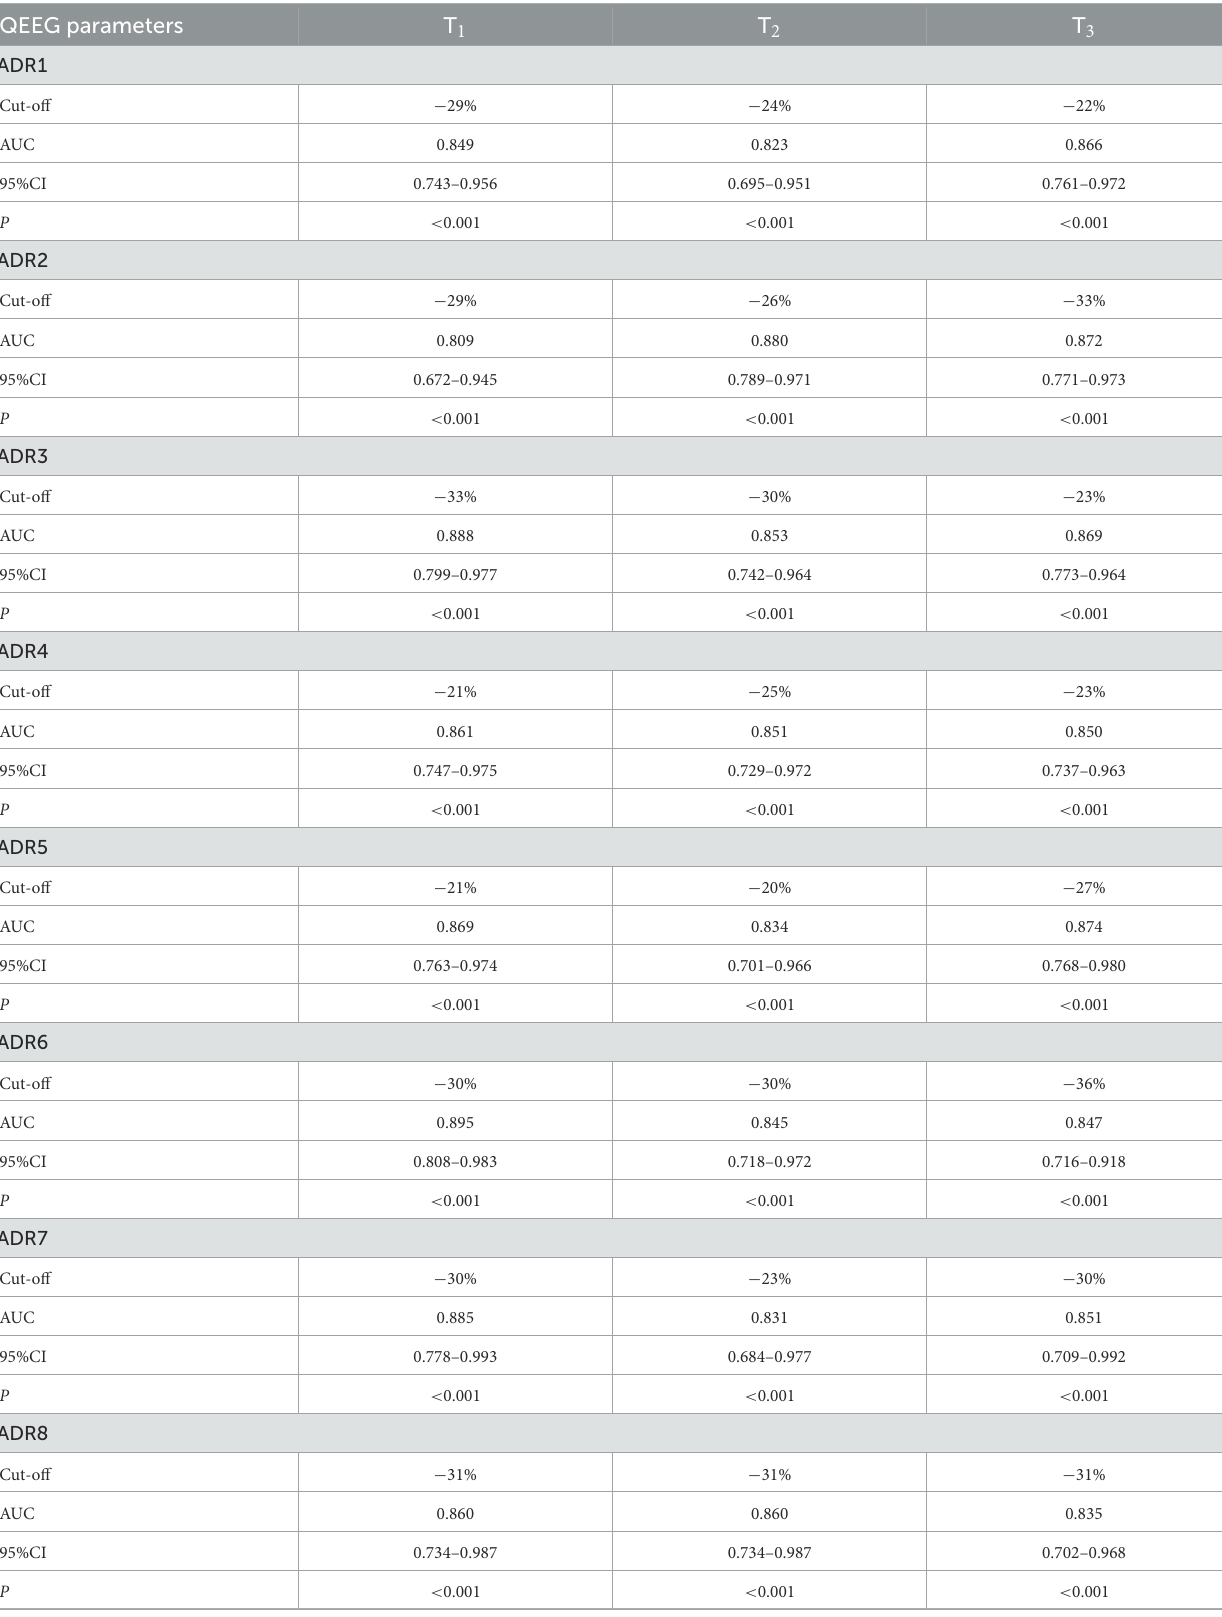
TABLE 3 ADR comparison of different leads at different time points on the surgical side undergoing CEA. QEEG